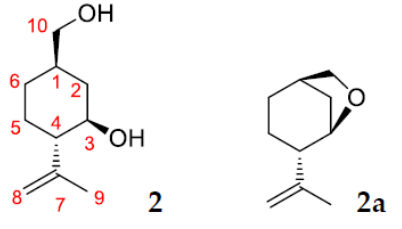
Figure 9. Structures 2 and 2a .